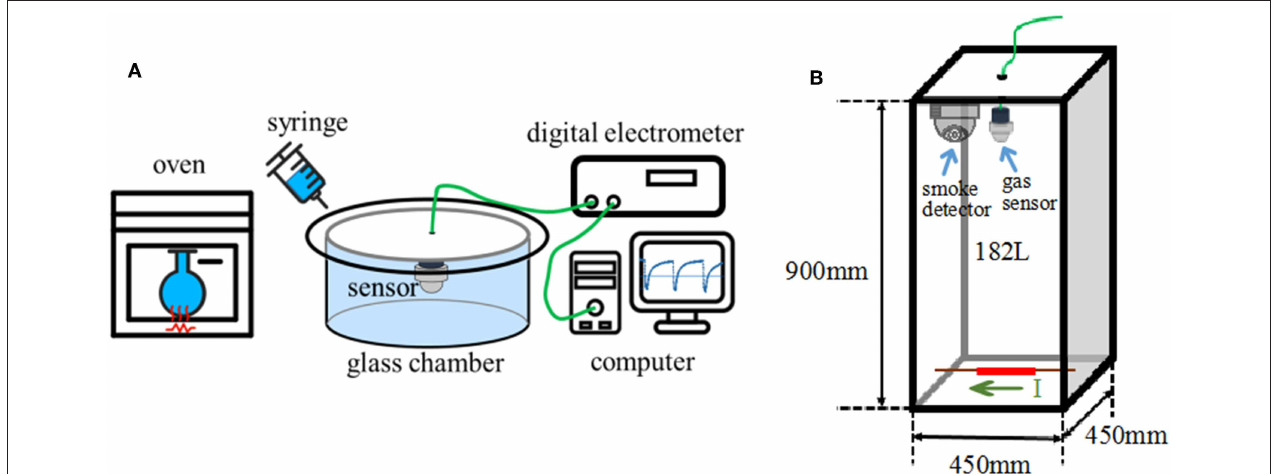
FIGURE 1 | Schematic diagrams of sensor tests. (A) Bench-scale test, (B) large-scale simulation